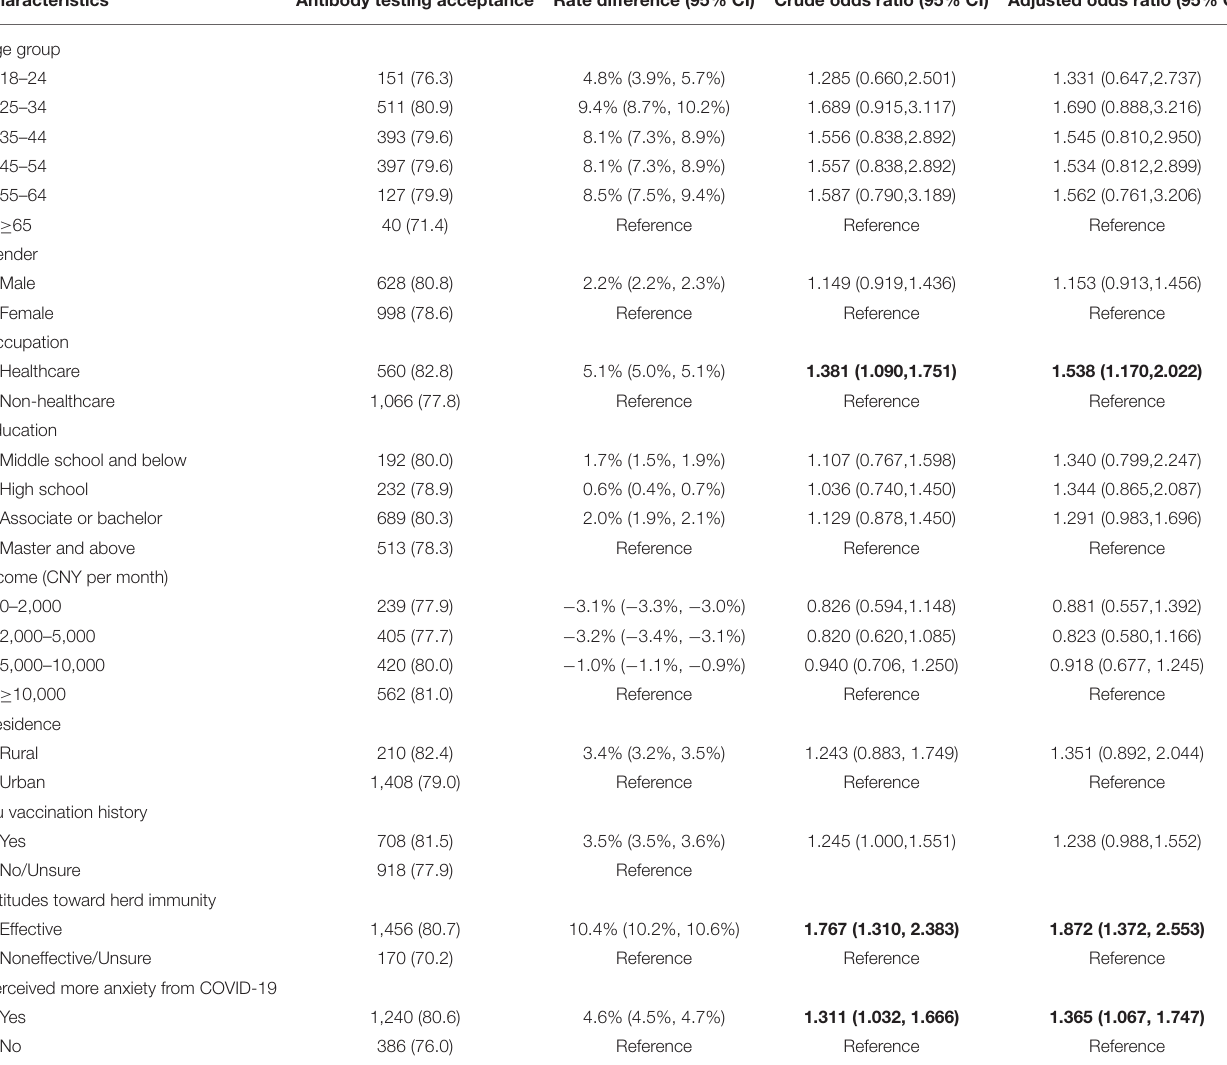
TABLE 3 | Influencing factors on antibody testing after COVID-19 vaccination.